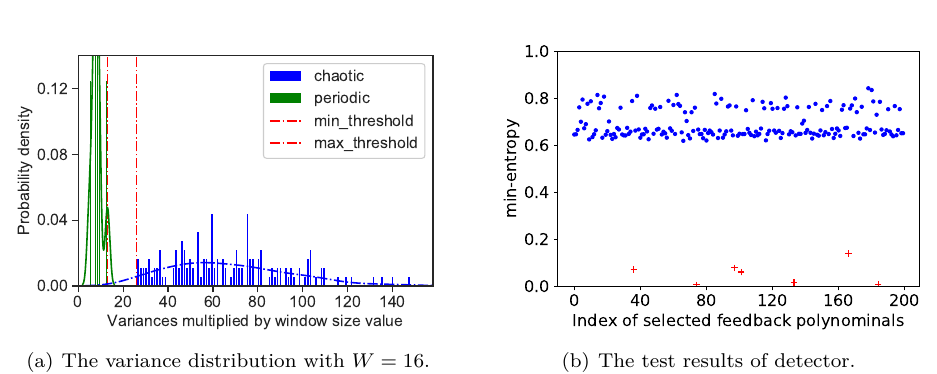
Figure 27: The variance distribution with W = 16 and the test results of the proposed